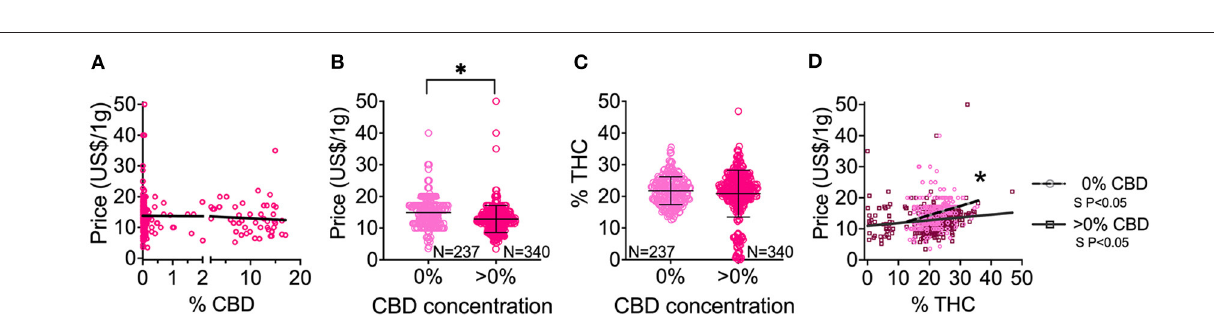
FIGURE 4 | Cannabis CBD content (absence 0% or presence > 0%) and price and THC associations in products with CBD information. (A) CBD and price correlation in herbal products. (B) Price distribution of products with 0% CBD in comparison to products with > 0% CBD. (C) THC content distribution of all herbal products with 0% CBD in comparison to products with > 0% CBD. (D) THC and price correlation comparing products with 0% CBD to products with > 0% CBD. * P < 0.05, between groups by Welch’s t -test (unpaired, two-tailed). Data shown as mean ± SD (B,C) . S P < 0.05 denotes significantly non-zero slope (D) ; * P < 0.05 between group slopes (D)